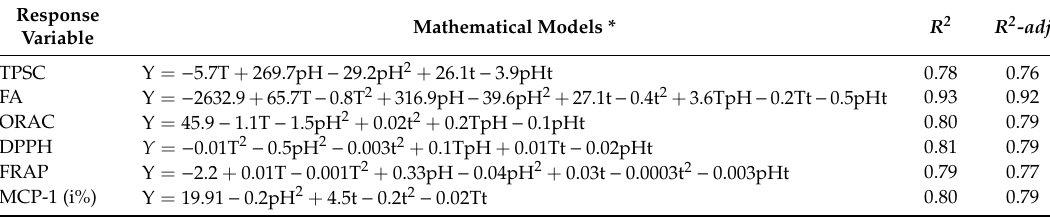
Table 5. Predicted models and regression coe ffi cients for the response variables of WB hydrolysates. Response